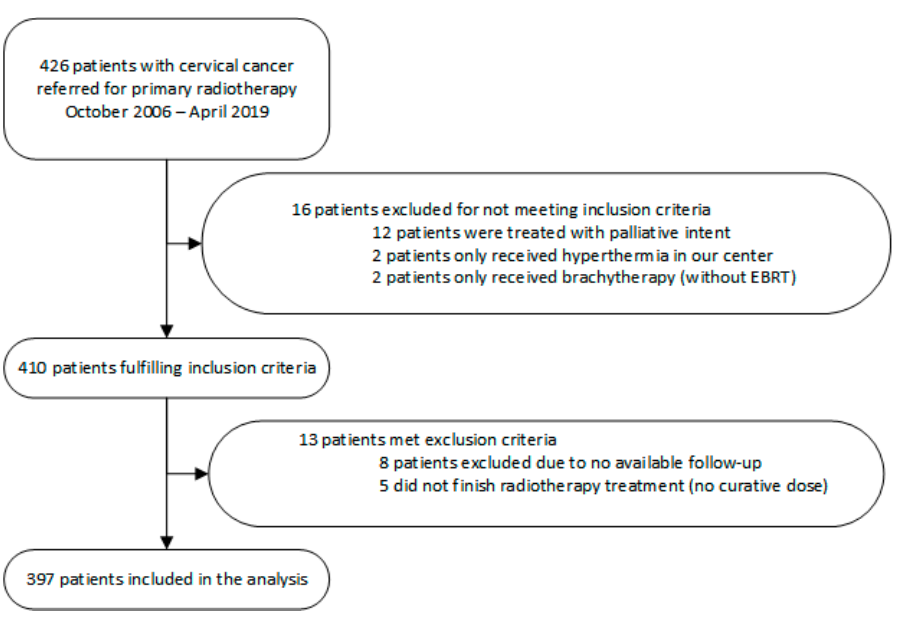
Figure 1. Patient inclusion and exclusion flowchart.